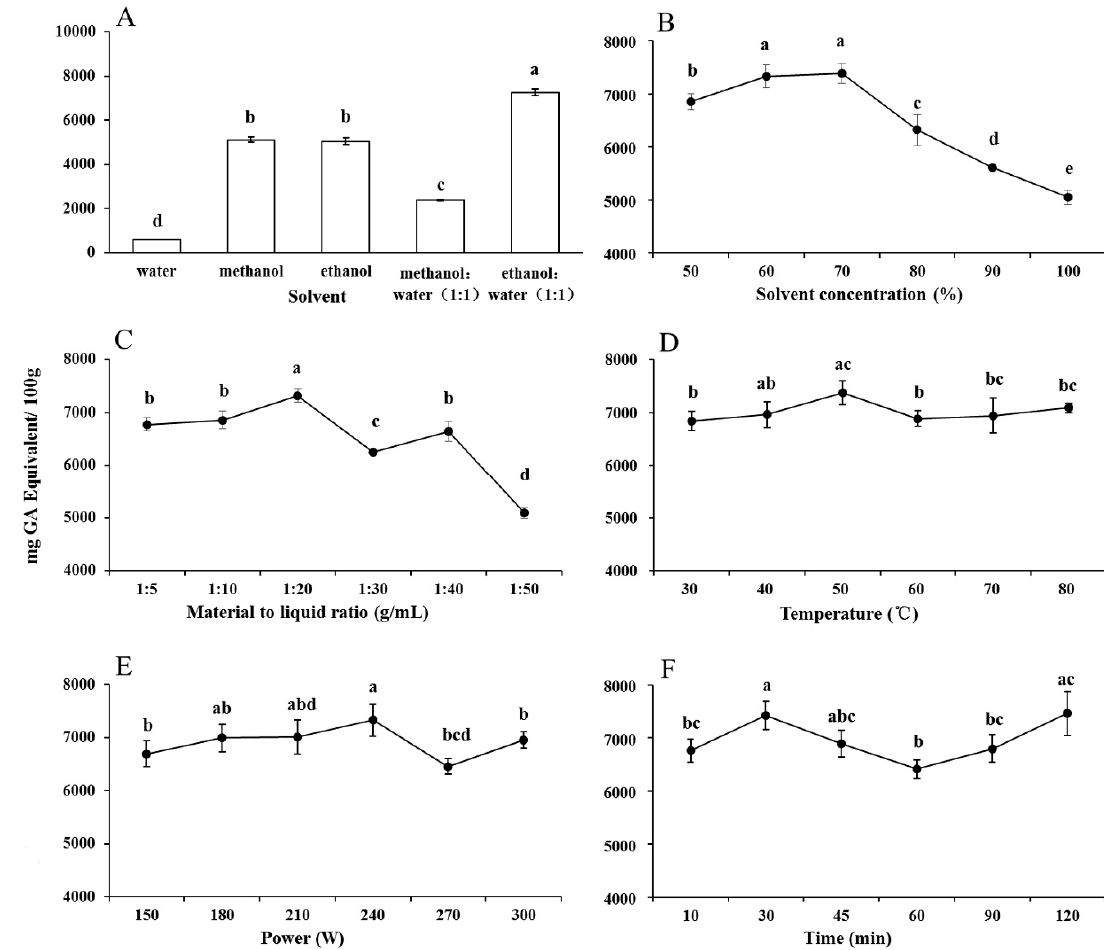
Figure 1. The effect of solvent type ( A ) and solvent concentration ( B ) extracted at 240 W, 50 ◦ C and 30 min, with material to liquid ratio at 1:20 g/mL, material to liquid ratio ( C , extracted at 240 W, 50 ◦ C, 30 min, and 70% aqueous ethanol), extraction temperature ( D , 240 W, 30 min, 70% aqueous ethanol, and 1:20 g/mL), sonication power ( E , 50 ◦ C, 30 min, 70% aqueous ethanol, and 1:20 g/mL), and extraction time ( F , 240 W, 50 ◦ C, 70% aqueous ethanol, and 1:20 g/mL) on the yields of total phenols in ATL by single factor test. Extraction was repeated thrice. Values marked by the same letter are not significantly different ( p < 0.05).